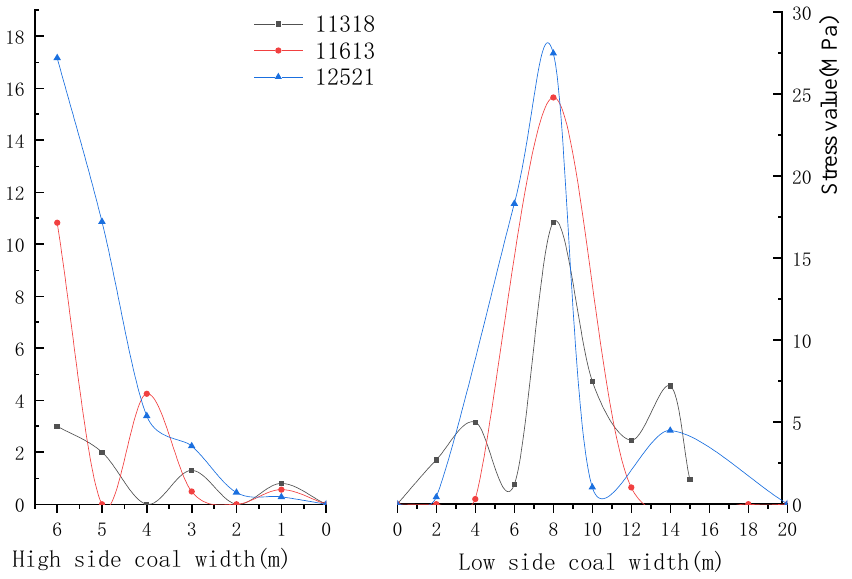
Figure 17. Comparison diagram of vertical stress increment of high and low sides at 25 m lead distance.